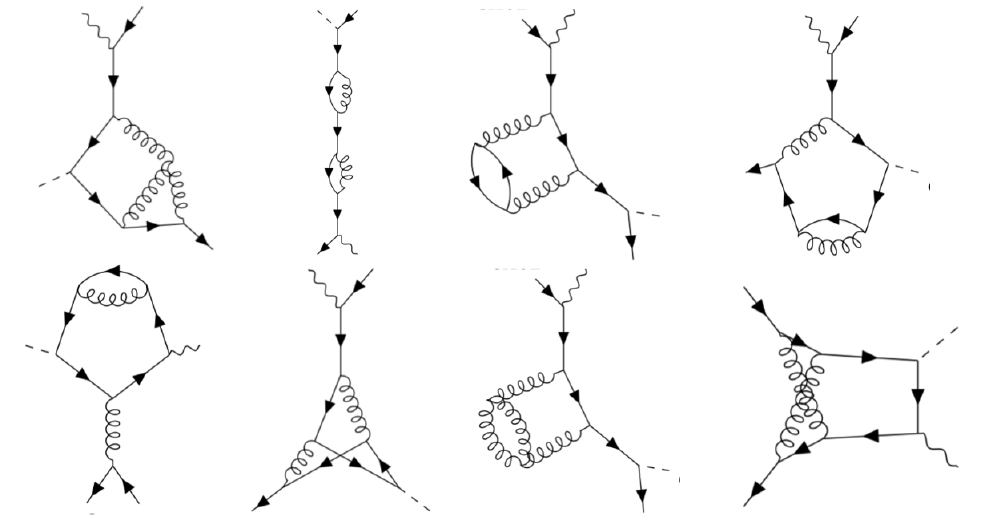
Figure 3 . Examples of non-singlet Feynman diagrams at two-loop